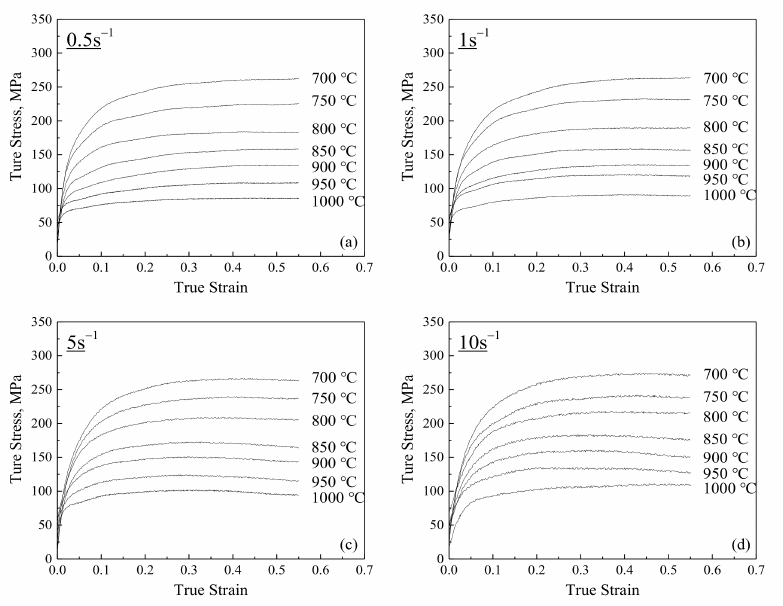
Figure 2. Flow-stress curves under different processes: ( a ) 0.5 s − 1 , ( b ) 1 s − 1 , ( c ) 5 s − 1 and ( d ) 10 s − 1 .